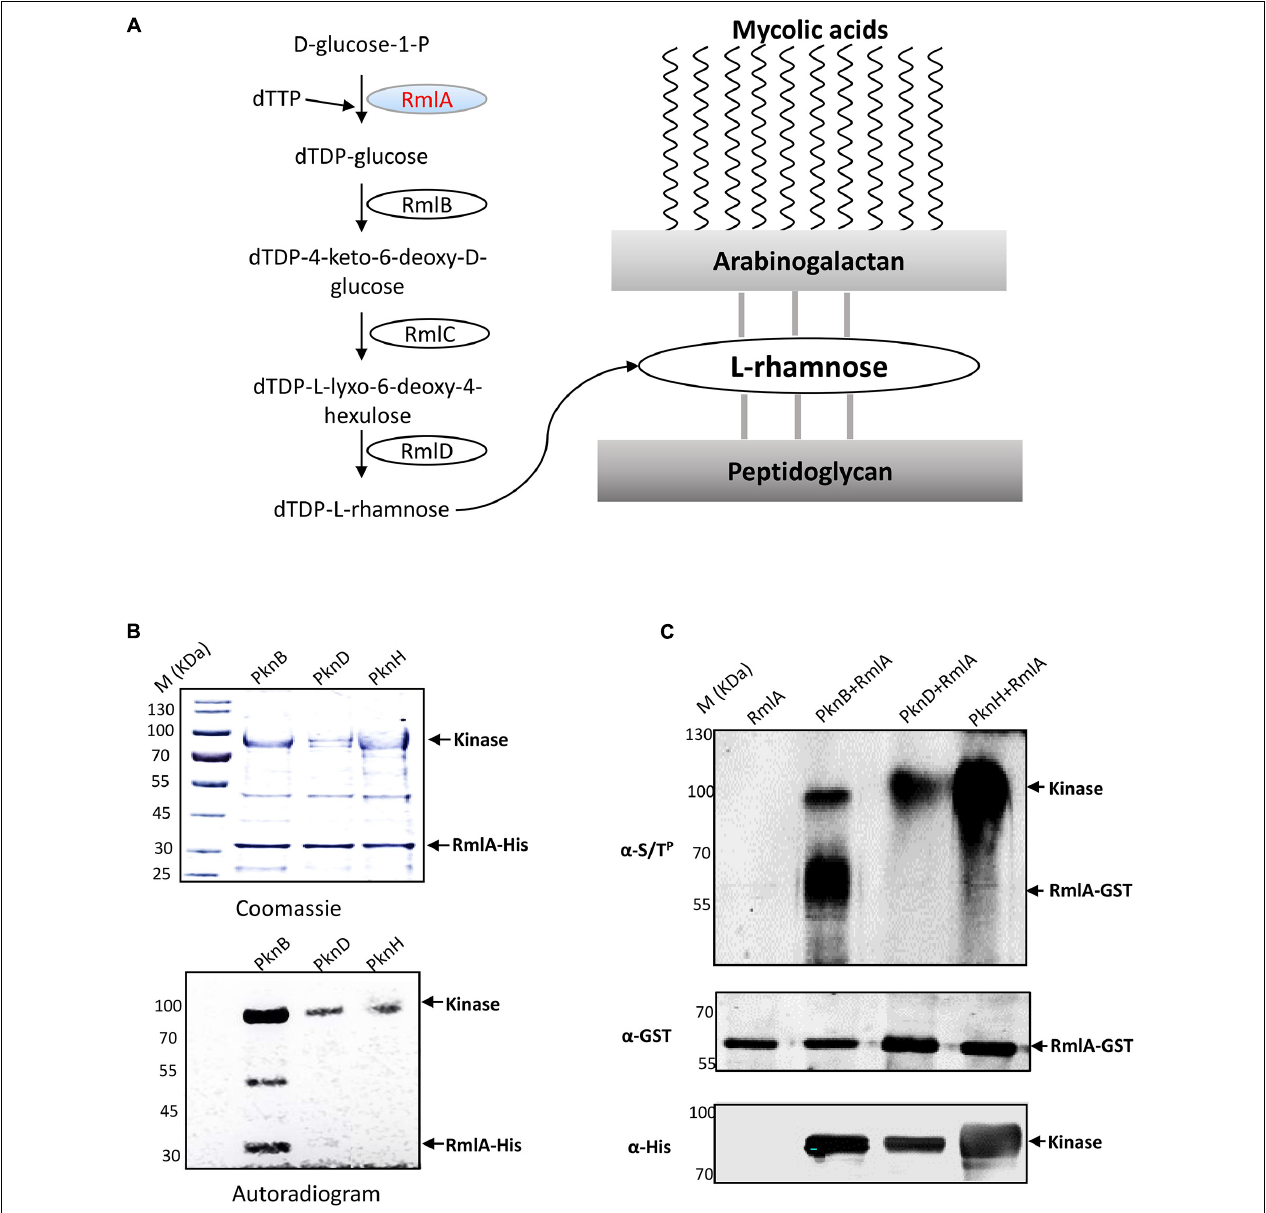
FIGURE 1 | RmlA, an important enzyme for L -rhamnose formation, is phosphorylated by PknB. (A) The biosynthesis pathway of cell wall linker- L -rhamnose. dTDP-rhamnose is the precursor of L -rhamnose. The biosynthetic pathway of dTDP-rhamnose consists of four steps from a- D -glucose-1-phosphate and TTP to dTDP-rhamnose. (B) In vitro phosphorylation of M. tuberculosis RmlA by STPKs. The three recombinant M. tuberculosis STPKs (PknB/D/H) were expressed and purified as His-tagged fusions and incubated with purified His-tagged RmlA and [ γ − 32 P] ATP. Samples were separated by SDS-PAGE, stained with Coomassie blue (upper panel), and visualized by autoradiography after overnight exposure to a film (lower panel). (C) In E. coli phosphorylation of M. tuberculosis RmlA by STPKs. rmlA gene was cloned into pDEST15 vector with a GST tag using the Gateway system, whereas the kinases ( pknB , pknD , and pknH ) were cloned into pET28a vector with His tag. The two plasmids were cotransformed into E. coli BL21 (DE3), and the RmlA and kinases were enriched with GST and Ni 2 + agarose beads, respectively. After immunoblotting, the phosphorylated signals were detected with an antithreonine phosphorylation